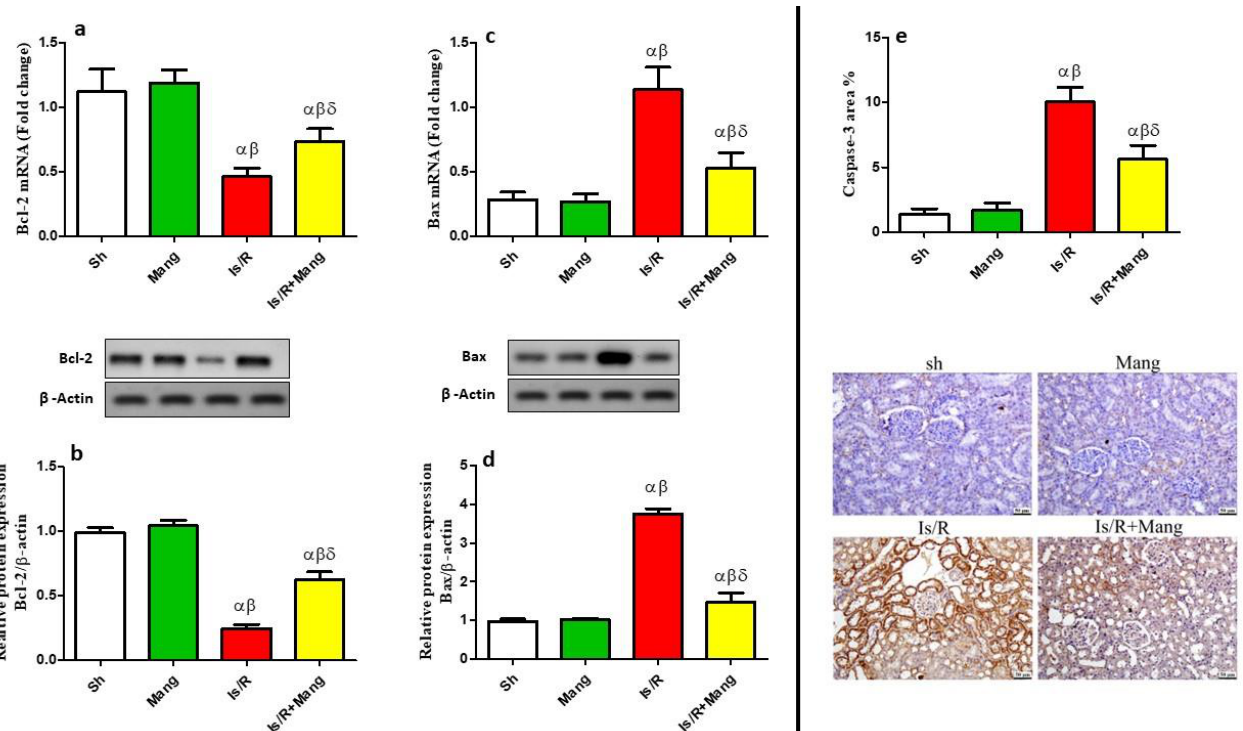
Figure 6. Mang’s (20 mg/kg, i.p) impact on ( a ) mRNA and ( b ) protein expression of renal Bcl-2, as well as ( c ) mRNA and ( d ) protein expression of renal Bax, and ( e ) IHC of caspase-3 protein. Data were articulated as the mean ( n = 7) ± SD, p value < 0.05 is significant. As compared with sham ( α ), Mang ( β ), and Is/R ( δ ) treated